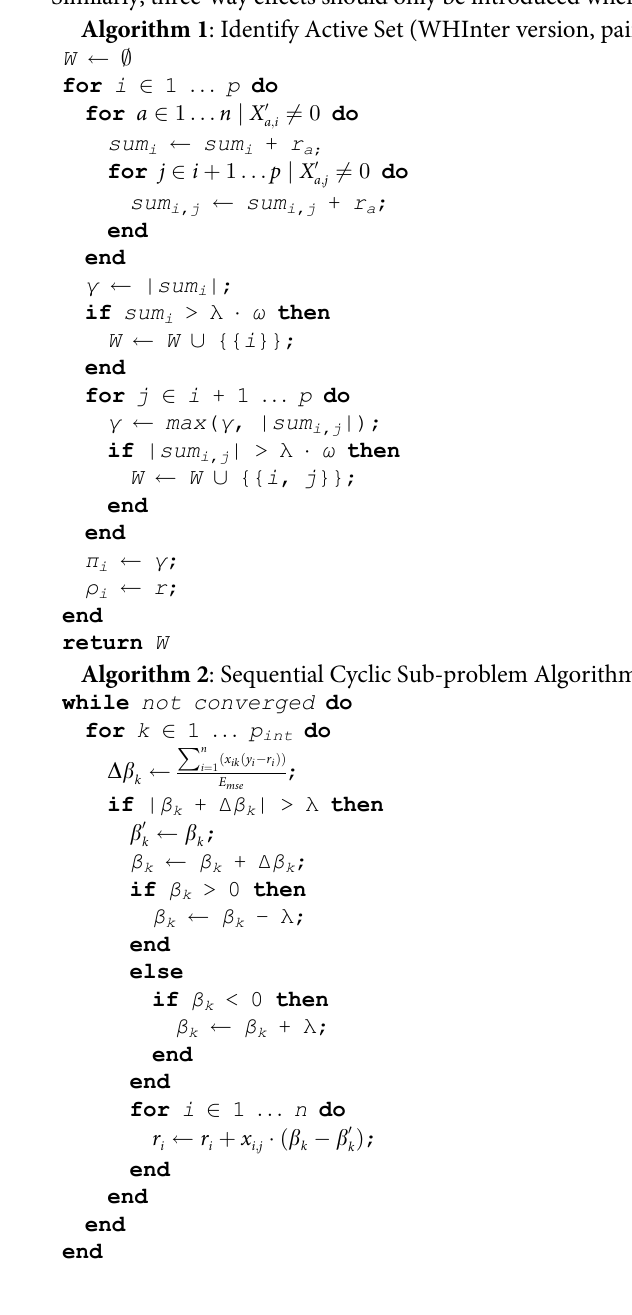
Algorithm 1 : Identify Active Set (WHInter version, pairwise interactions only).